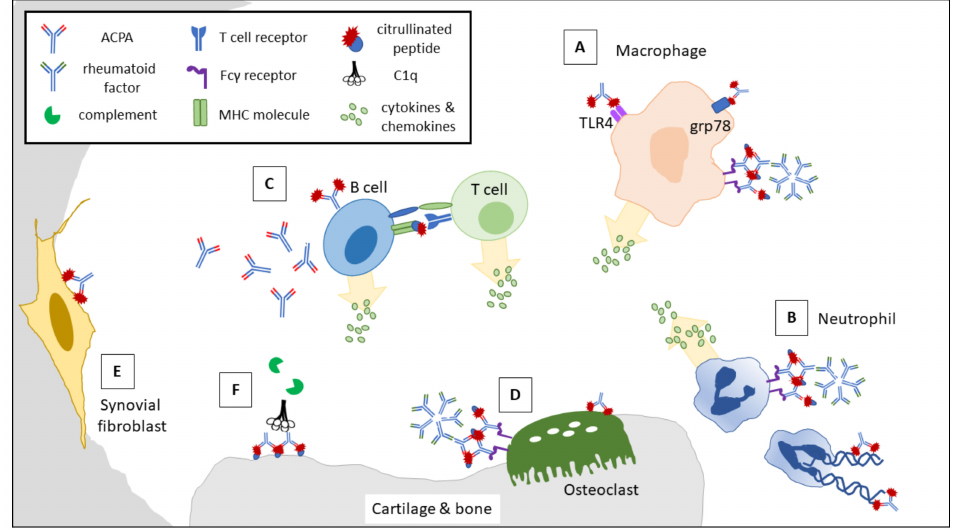
Figure 1. ACPA-related RA immunopathogenesis. ACPAs activate macrophages via IC formation and agonistic activity. They bind to the grp78 protein and TLR4 on the cell surface to elicit an inflammatory response. Additionally, through the binding of ICs and Fc γ R, proinflammatory cytokines and M-CSF are released ( A ). Neutrophils and ACPAs interact in a self-perpetuating manner. As NETosis releases massive amounts of citrullinated antigens to drive ACPA production, the ACPA formation of ICs promotes further neutrophil netting and the release of degradative enzymes and reactive oxygen species upon binding with Fc γ R ( B ). Autoreactive B cells baring surface ACPAs can serve as APCs to promote citrulline-specific T cell maturation / di ff erentiation and secrete various proinflammatory cytokines ( C ). Direct ACPA targeting enhances osteoclast di ff erentiation. The binding of ICs via Fc γ R activates osteoclasts and promotes proinflammatory cytokine production ( D ). ACPAs interact with citrullinated cellular proteins and enhance fibroblast migration ( E ). Complement activation takes place via both the classical pathway and the alternative pathway. ACPAs also cross-react with type II collagen within joint cartilage, resulting in joint destruction ( F ). ACPAs, anti-citrullinated peptide antibodies; RA, rheumatoid arthritis; TLR4, Toll-like receptor 4; Fc γ R, Fc gamma receptors; IC, immune complex; C5a, complement 5a; M-CSF, macrophage colony-stimulating